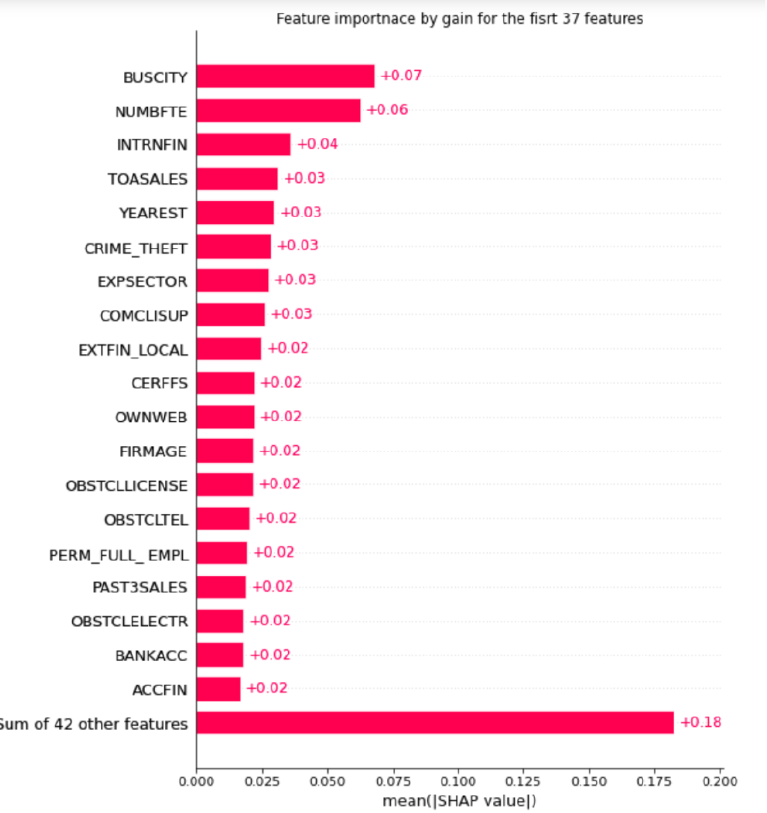
Figure 1: Feature Importance by Gain for The First 37